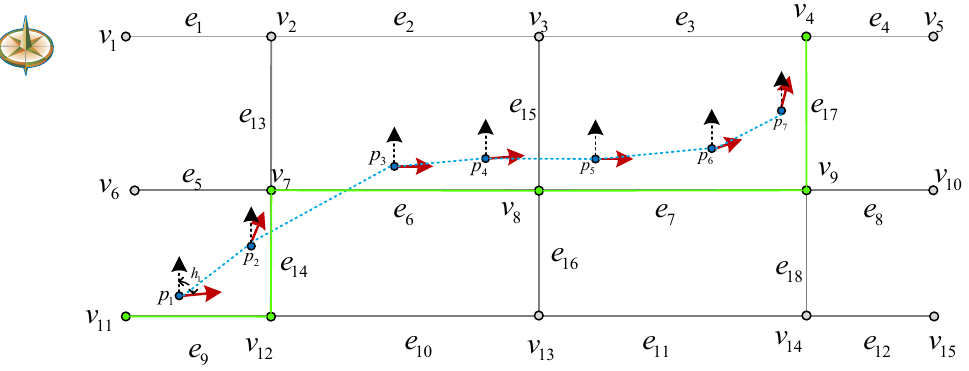
Figure 1. Example of trajectory data and road network model.